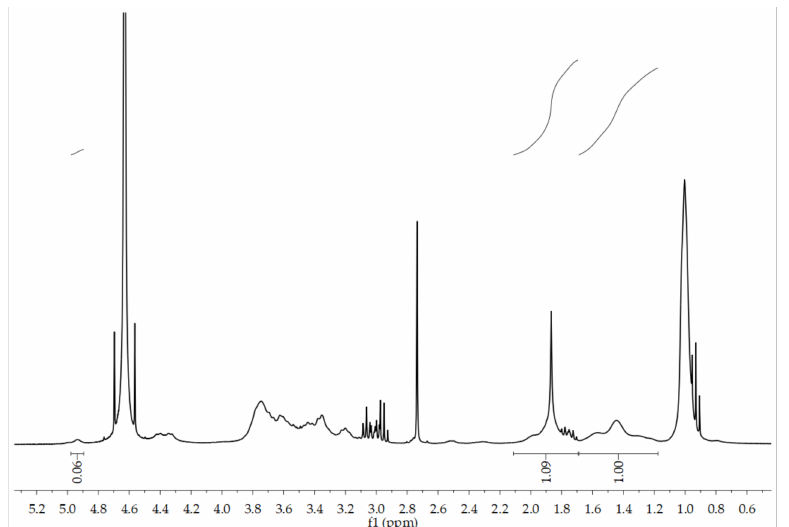
Figure 2. 1 H NMR spectrum of